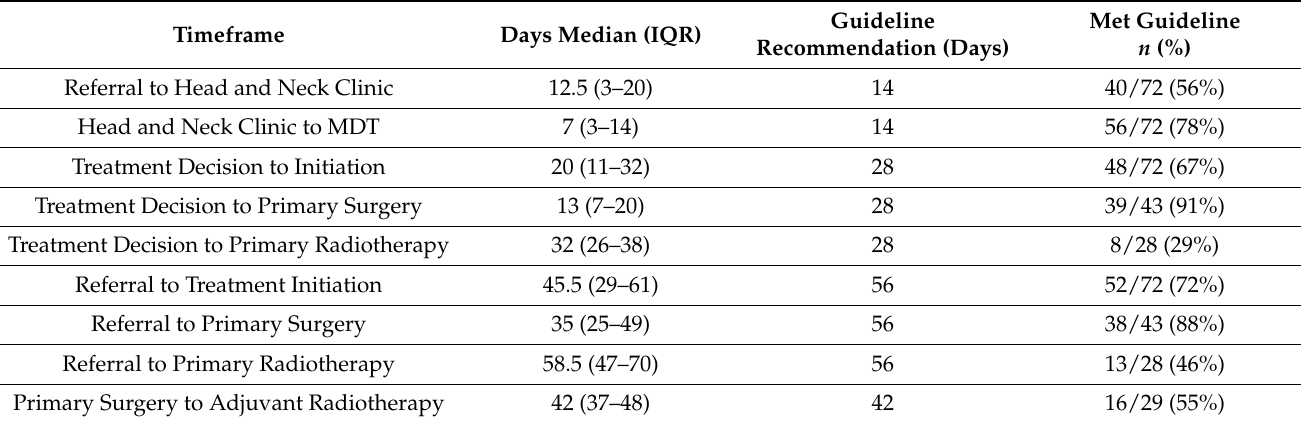
Table 2. Timeframes for head and neck cancer treatment at Flinders Medical Centre in 2018 and 2019 compared to Australian guidelines.